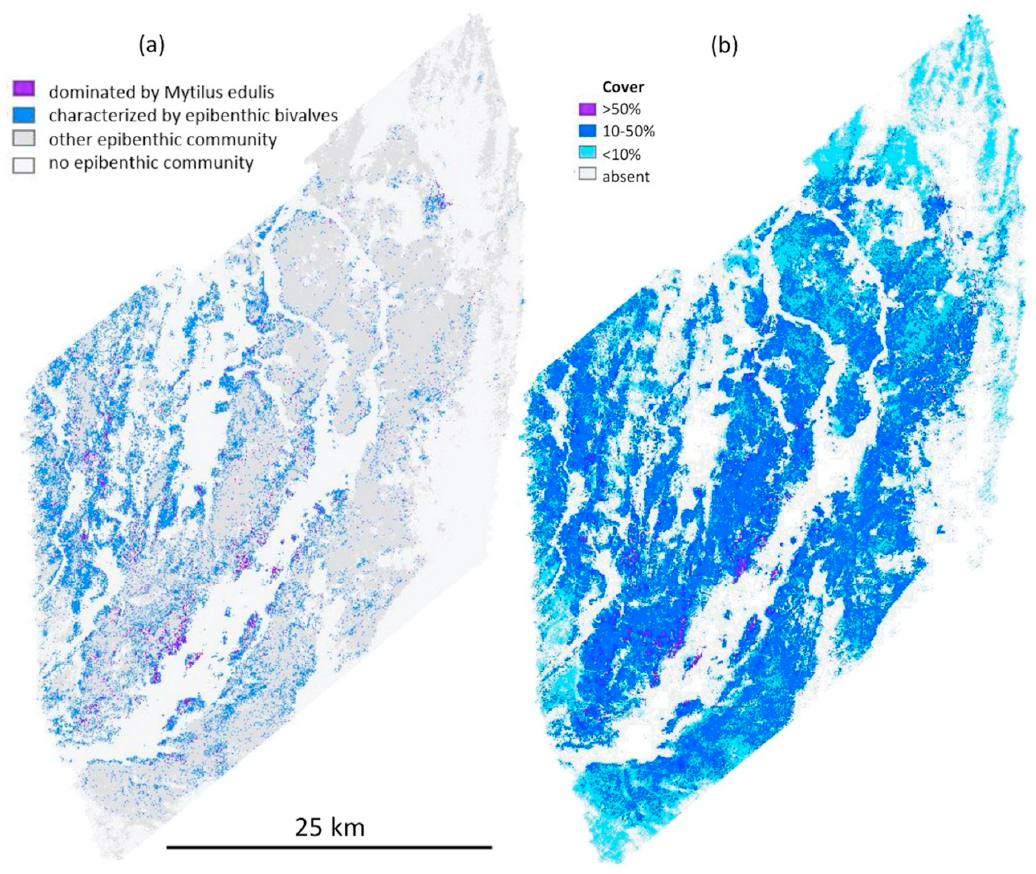
Figure 16. Comparison of Mytilus spp. maps from HUB classes versus the continuous prediction ( a ) Mytilus classes from HUB level 4–6 map (characterized by = 10–50%, dominated by = > 50% cover), ( b ) Mytilus classes extracted from percent coverage prediction (absent, 0–10%, 10–50% and >50%).